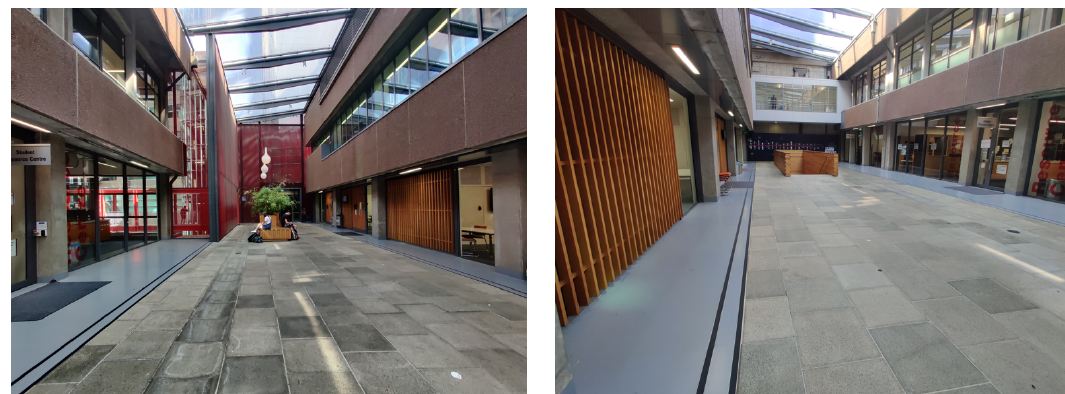
Figure 3. Foyer of the building used for the walking condition, selected to simulate the real walking conditions that smartphone users might experience in daily life.